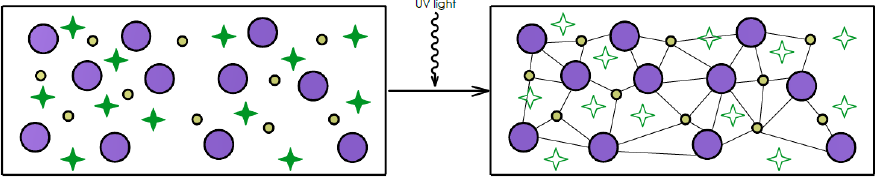
Figure 3. Liquid photopolymer (on the left), induced polymerization by light (small circle — monomer, large circle — oligomer, star — photoinitiator).